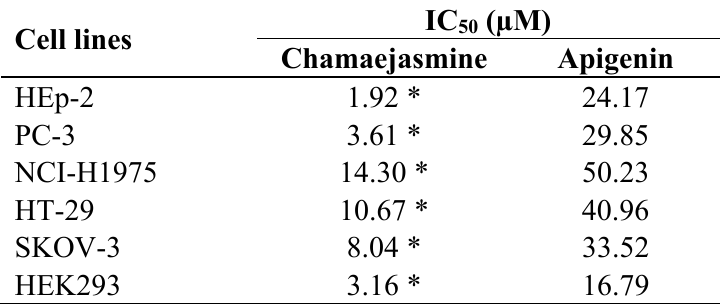
) values for chamaejasmine towards 50